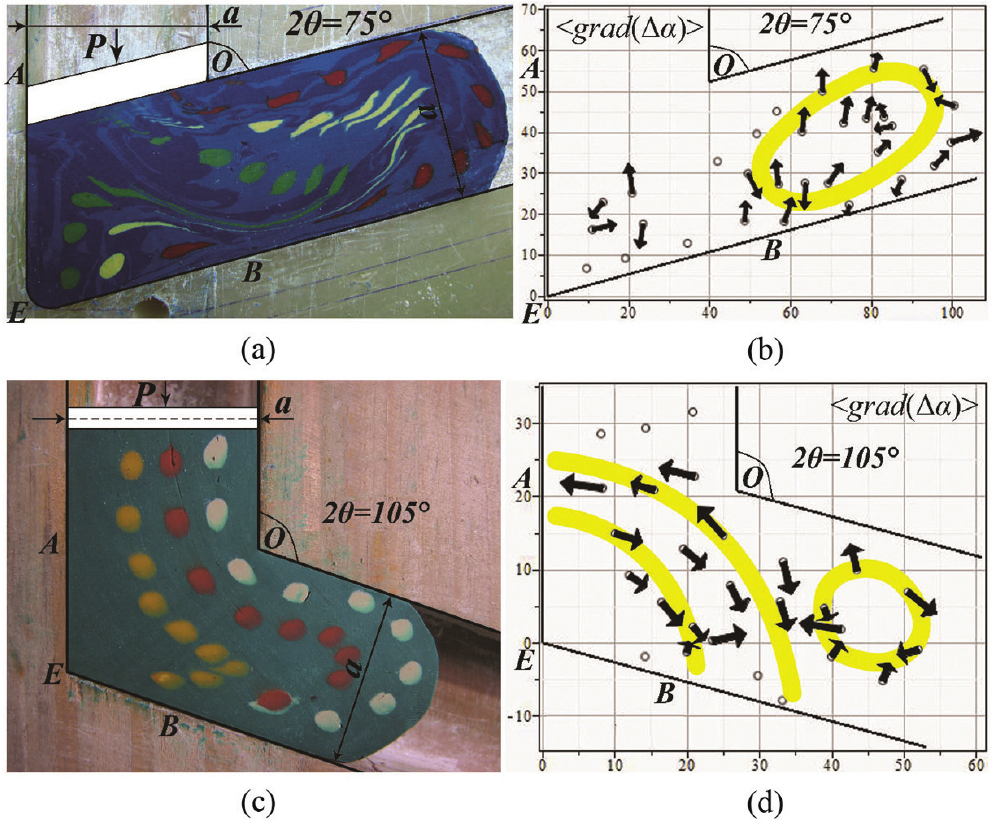
Figure 1. Physical simulation of ECAE through non-rectangular 2 θ -dies with channel intersection angles 2 θ =75° ( a , b ) and 2 θ =105° ( c , d ) showing dead zones AEB formation as well as the formation of material macroscopic rotation in outlet channels OEB ( a , c ); and experimental vector fields of macroscopic rotation gradients ( b , d